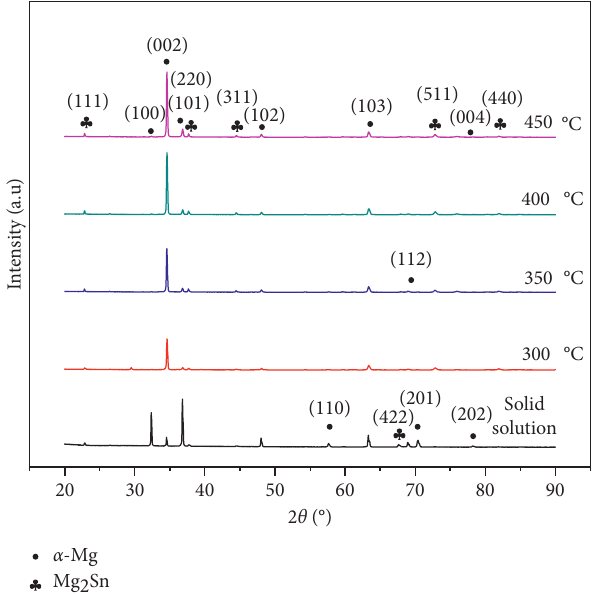
Figure 1: XRD patterns of Mg-6Sn-3Al-Zn alloys without and with rolling at different